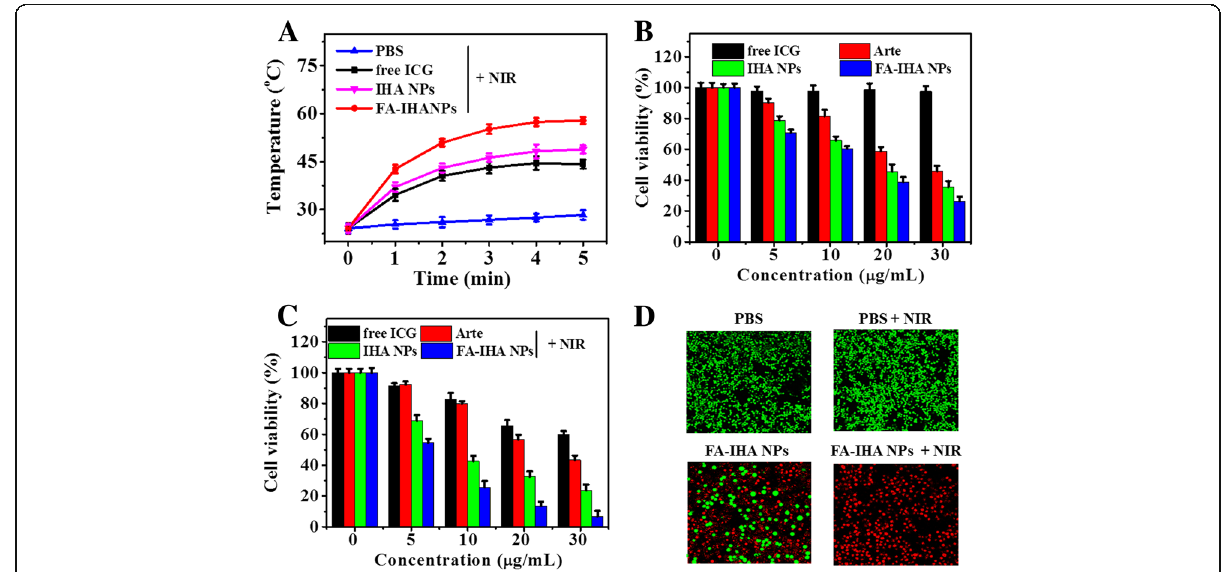
Fig. 7 a Temperature change curves of PBS-, free ICG-, IHA NPs-, and FA-IHA NPs-treated cells in 96-well plates after 5 min of NIR irradiation. b, c Cell viability of cells treated with free ICG, Arte, IHA NPs, and FA-IHA NPs without or with 808 nm laser irradiation (5 min, 1 W/cm 2 ), respectively. d Calcium AM/PI dual-staining images of cells after treatment with PBS (control), PBS+NIR, FA-IHA NPs, and FA-IHA NPs+NIR,